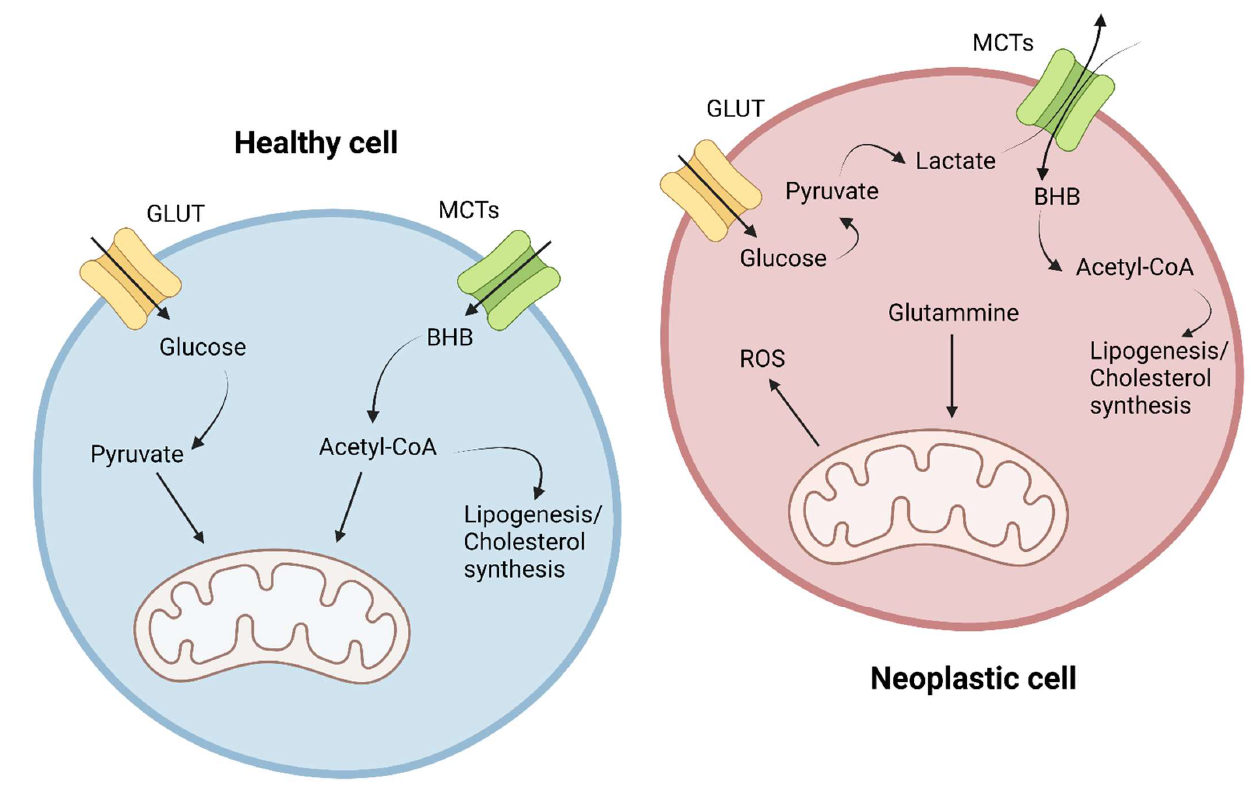
Figure 3. Metabolic differences in the utilization of glucose and ketone bodies in healthy cells and cancer cells.